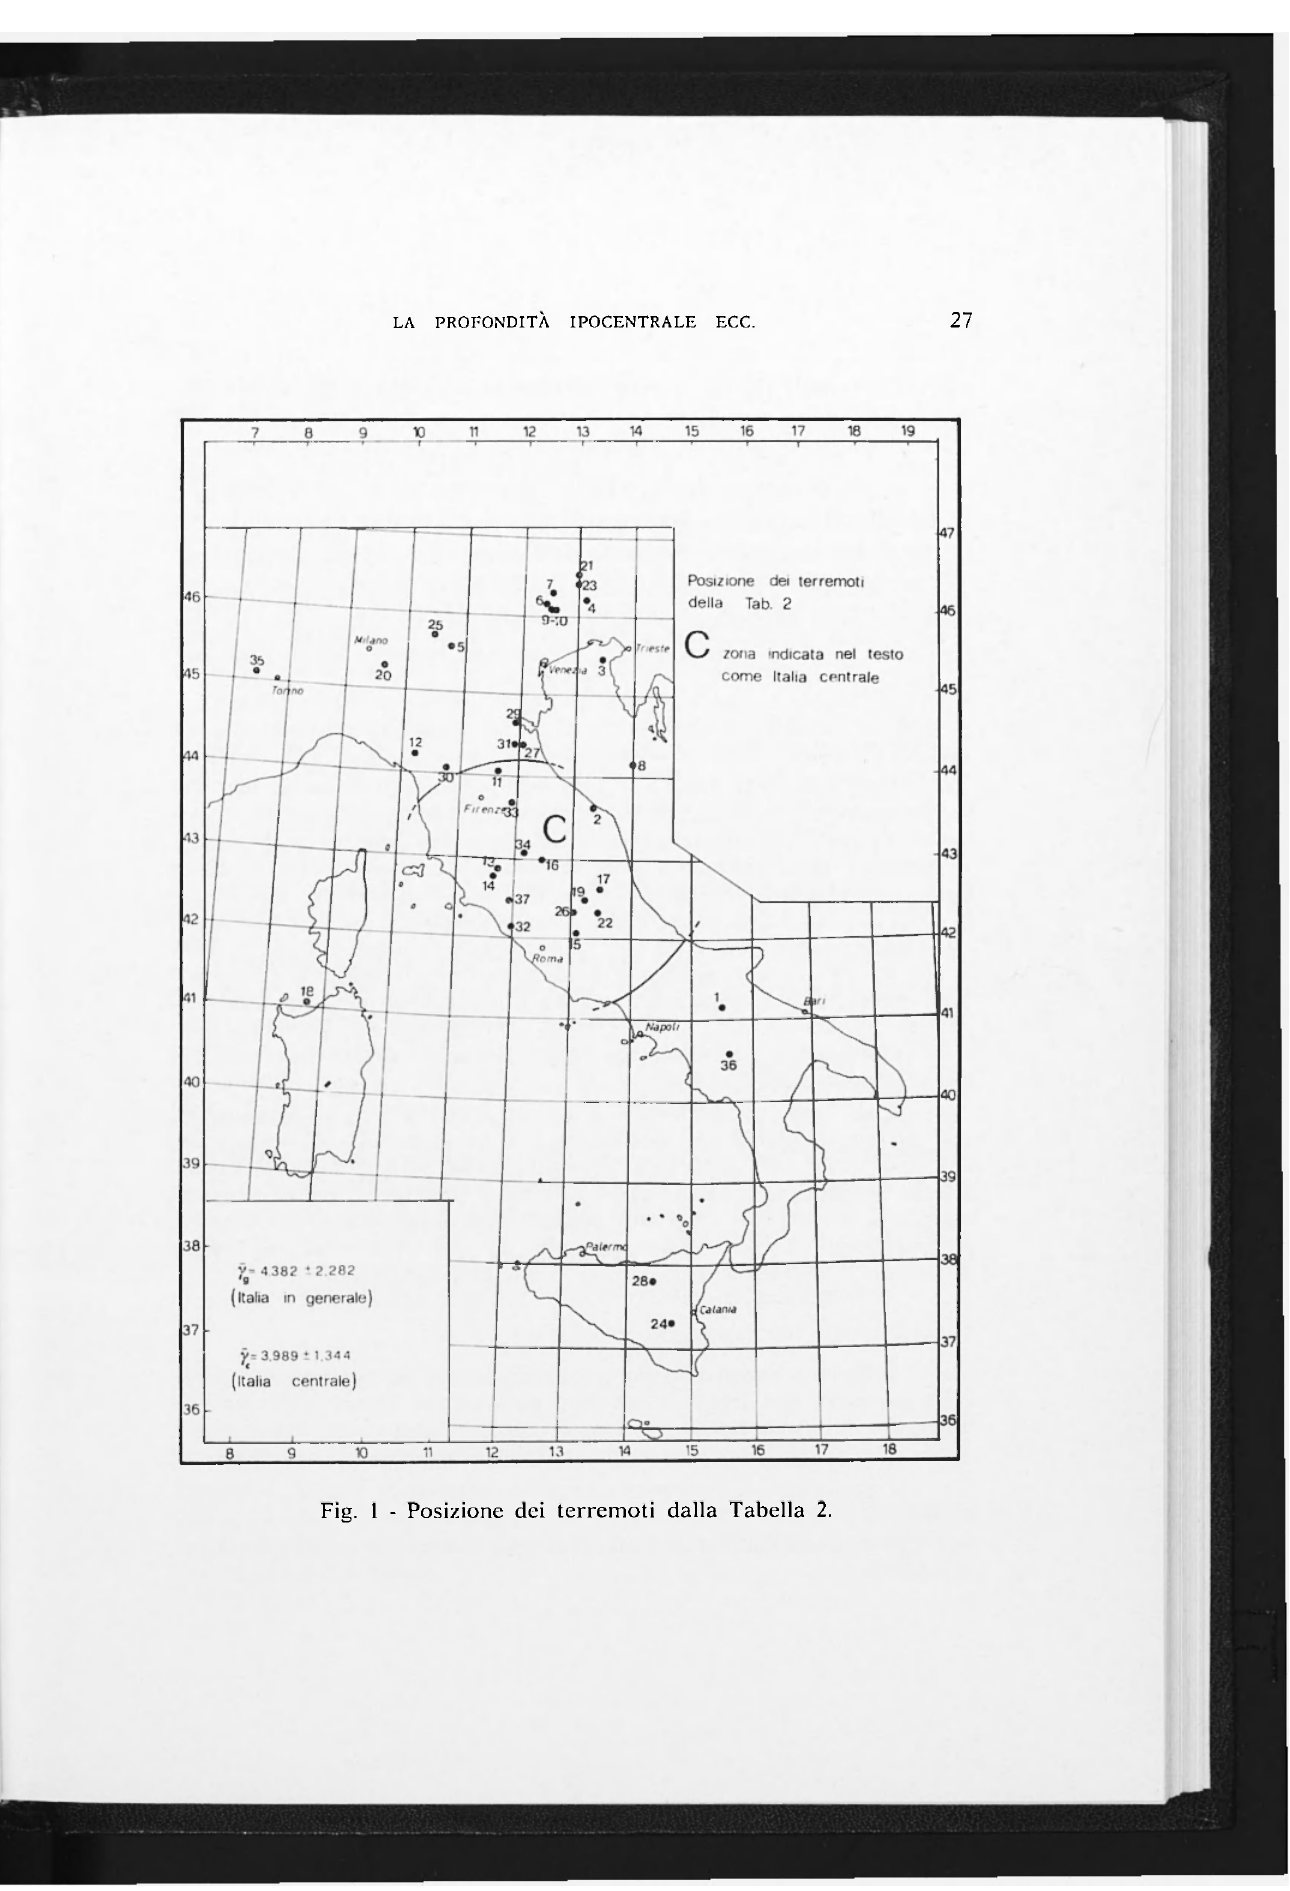
Fig. 1 - Posizione dei terremoti dalla Tabella